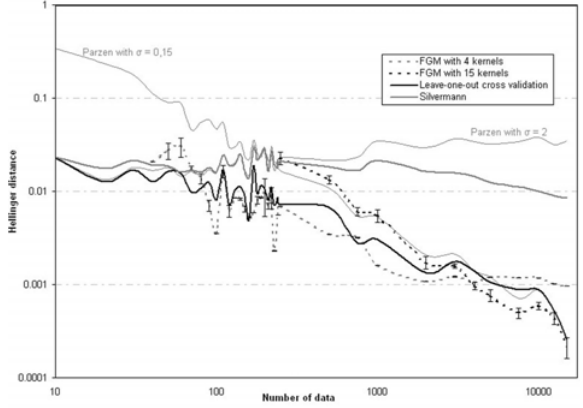
Figure 10. Comparison between the PDF estimation methods with varying number of